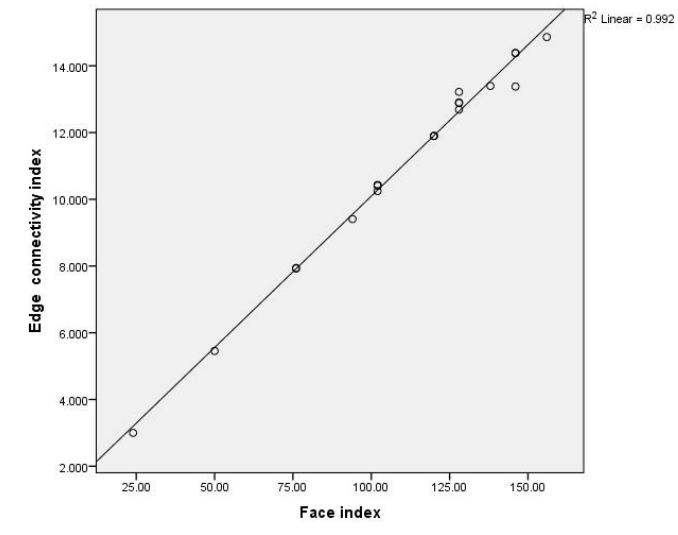
Figure 3. Plot of the face index versus edge connectivity index for 21 benzenoid